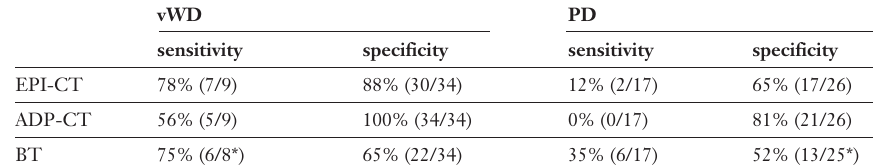
Sensitivity and speci- ficity of the PFA-100 ® and the bleeding time (BT) to detect von Willebrand dis- ease (vWD) or mild platelet function disorder